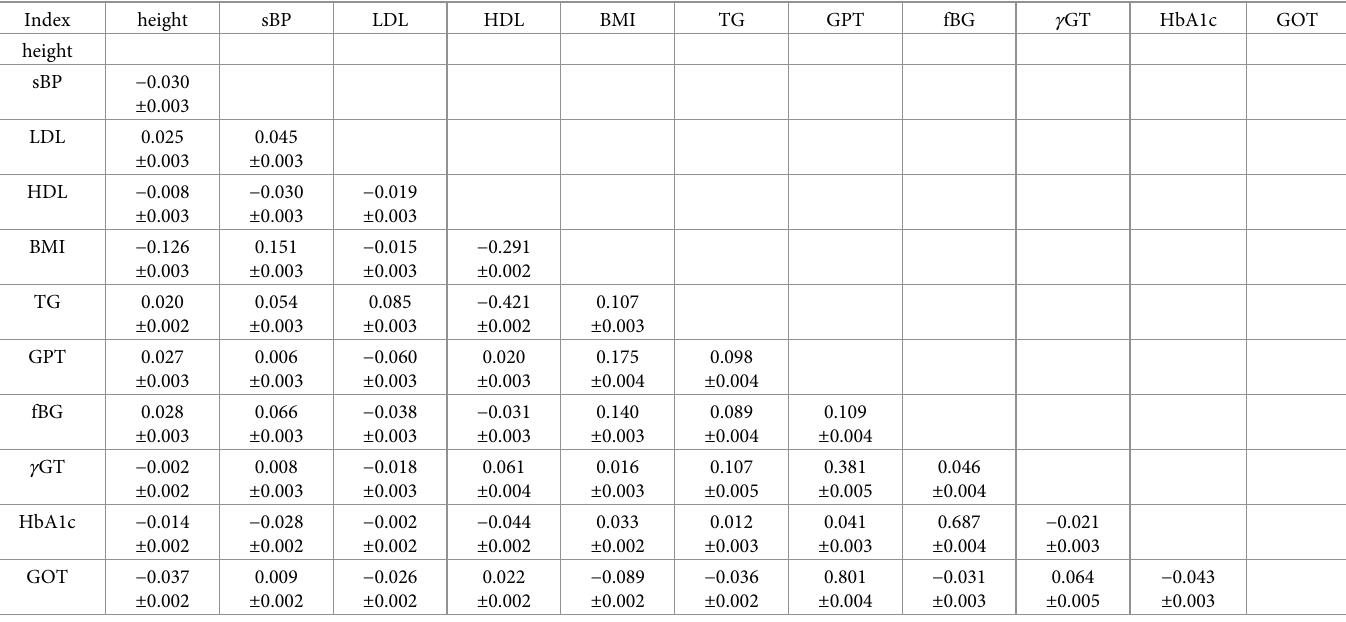
Table 4. Correlation coefficients with standard deviation in the B matrix.